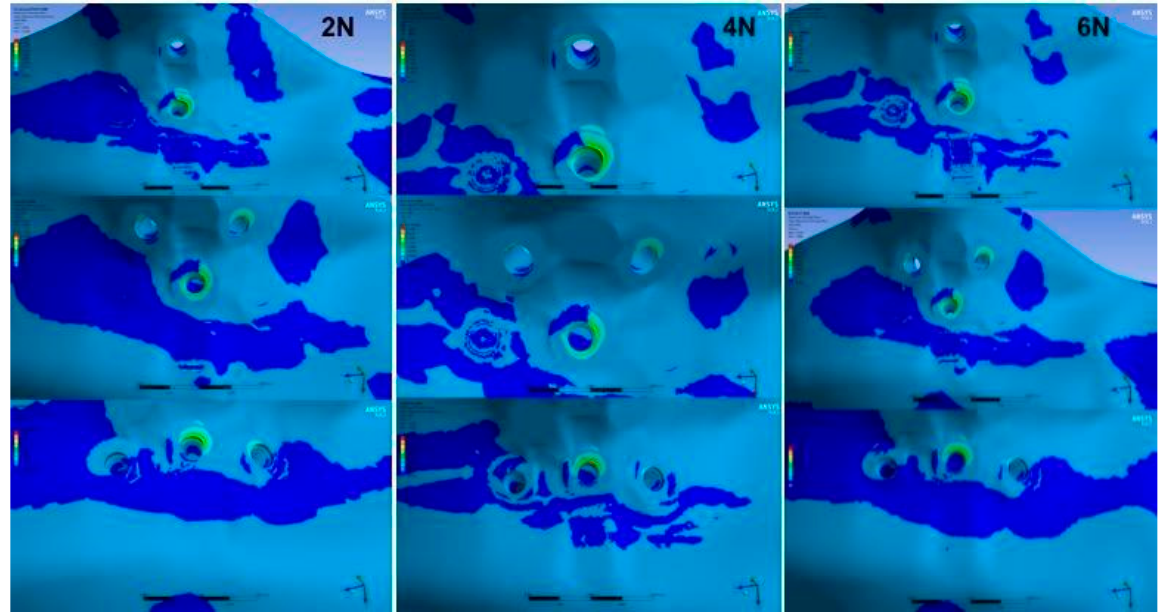
Figure 7. Mesh generated from the three-dimensional model.